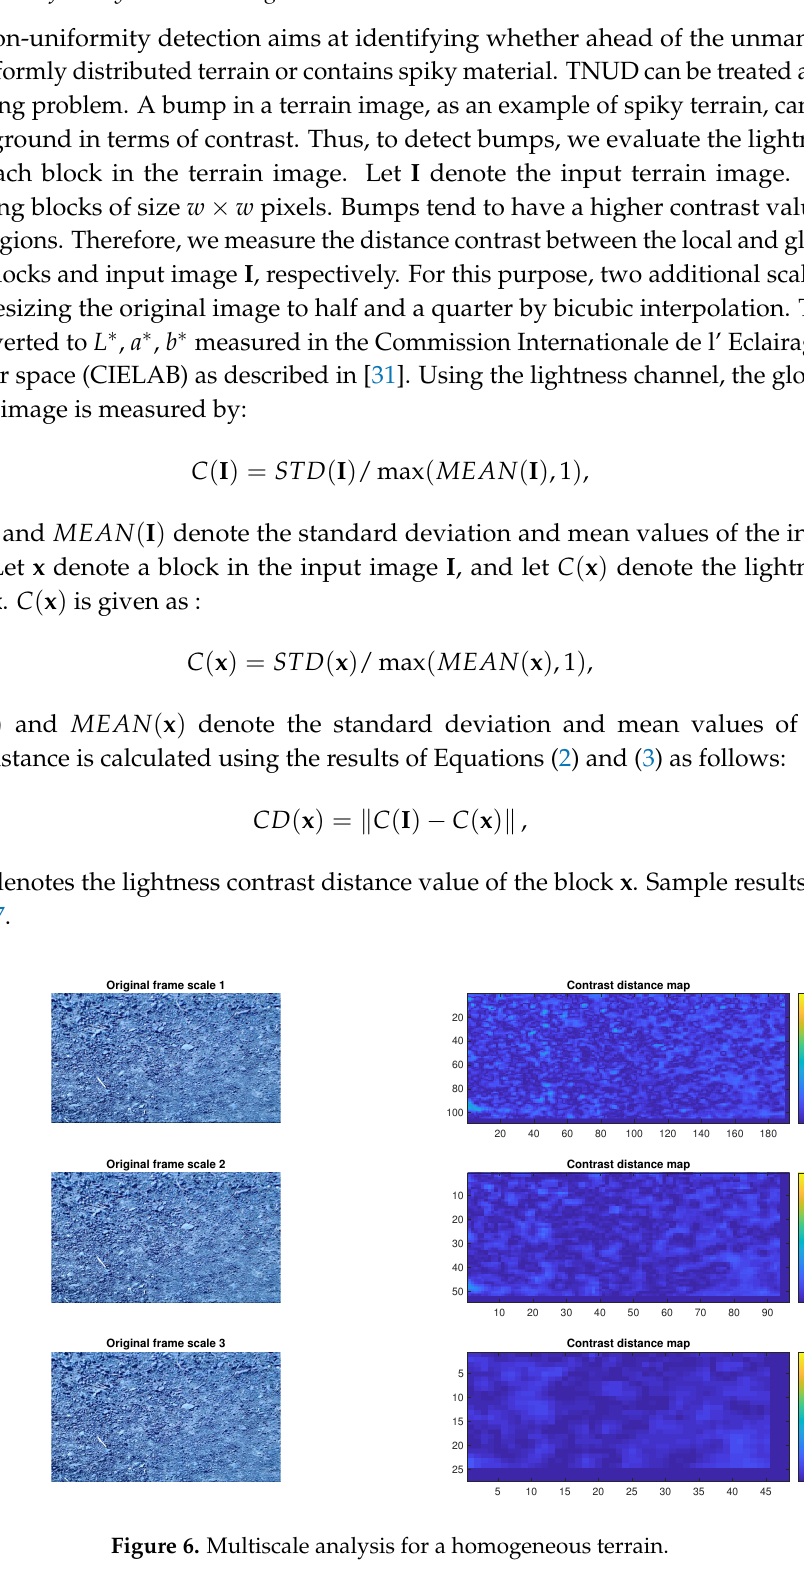
Figure 6. Multiscale analysis for a homogeneous